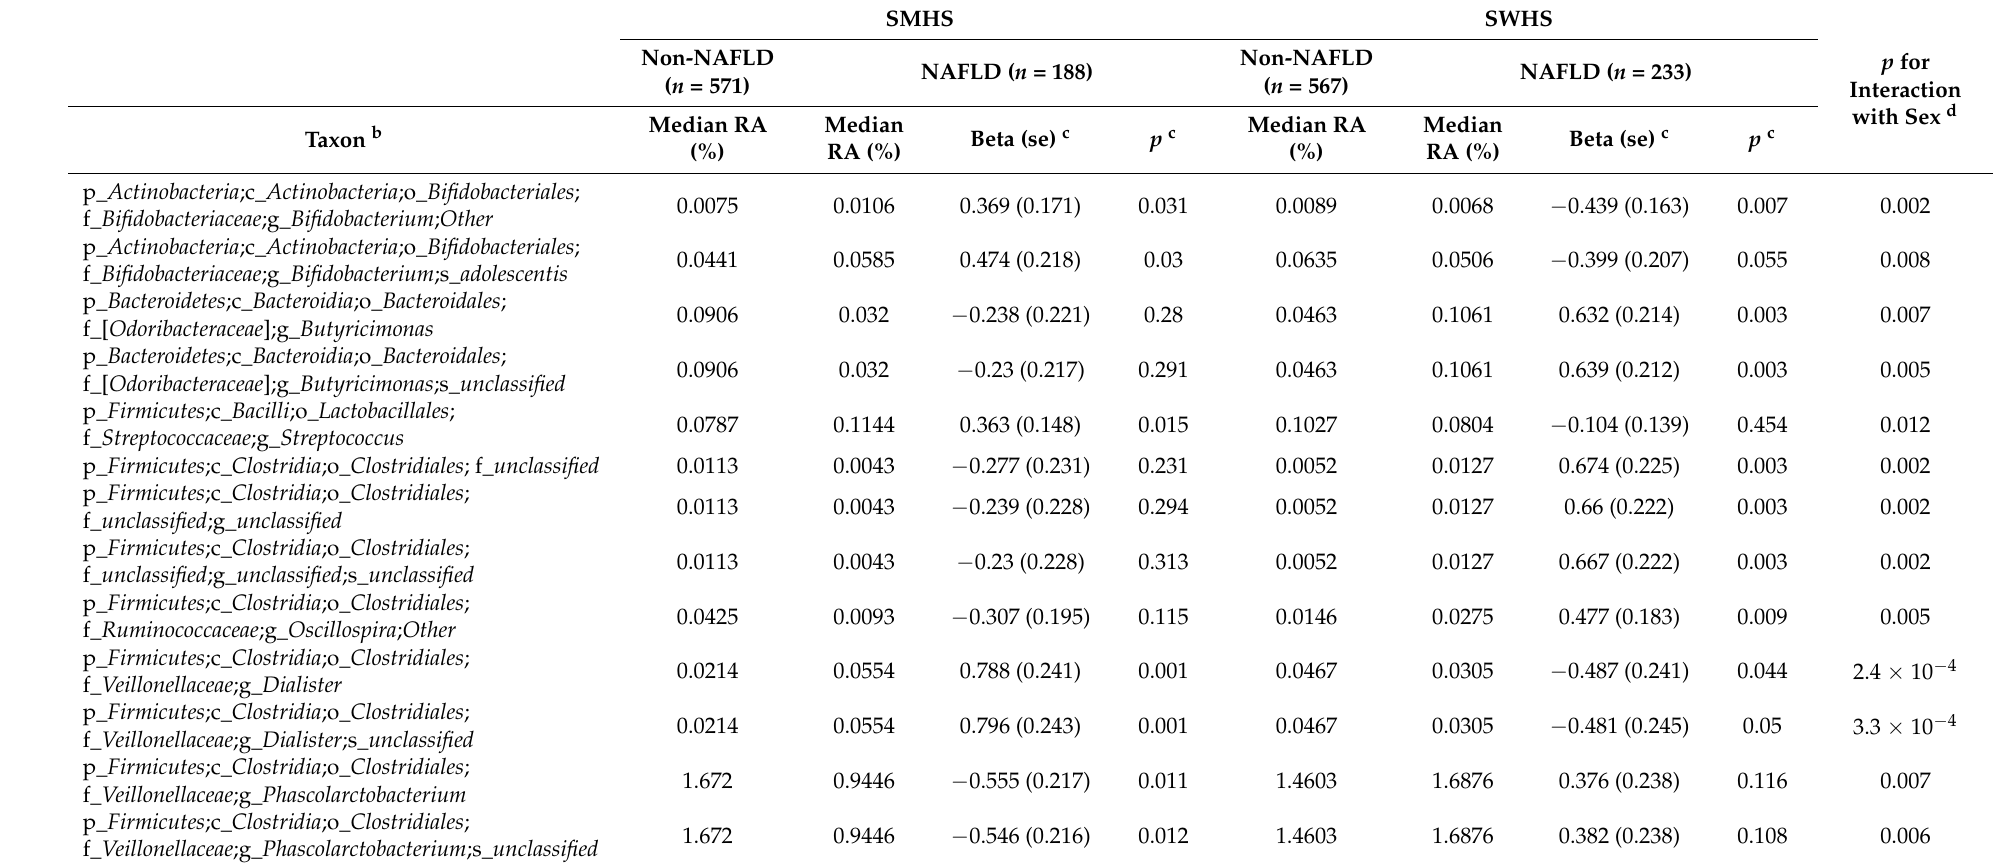
Table 2. Sex-dependent association of non-alcoholic fatty liver disease and common bacterial taxa a . SMHS SWHS